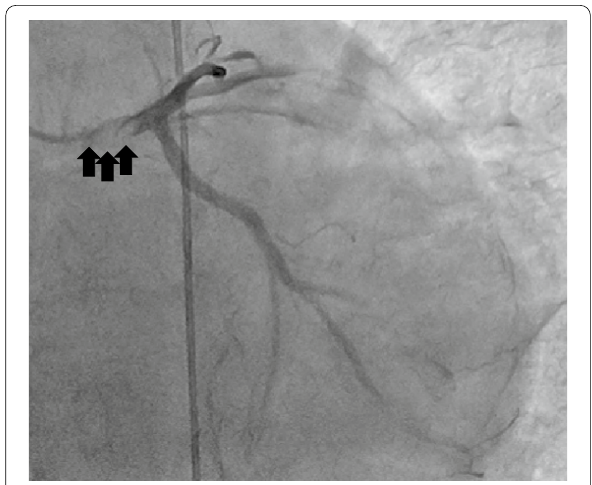
Fig. 1 Coronary angiography revealed obstruction of the left main coronary trunk by a vegetation (black arrow)